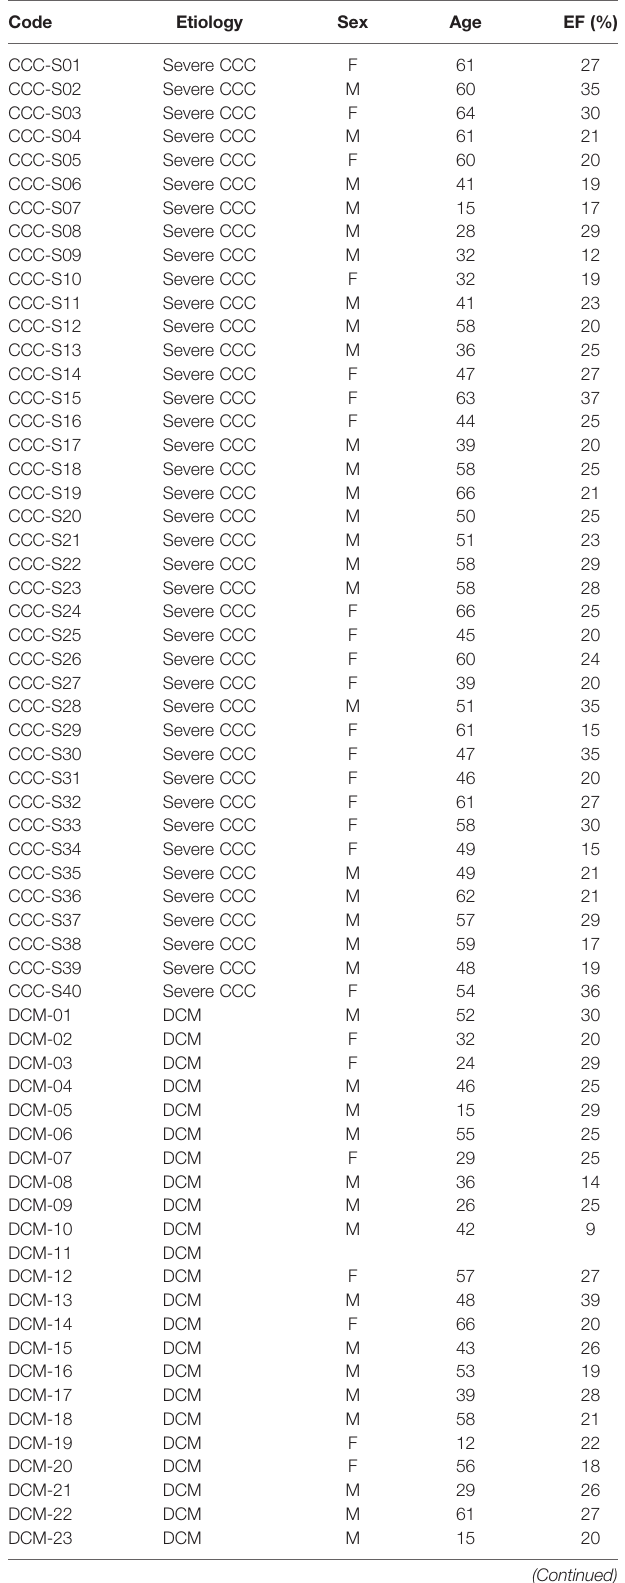
TABLE 1 | List of the patients included in this